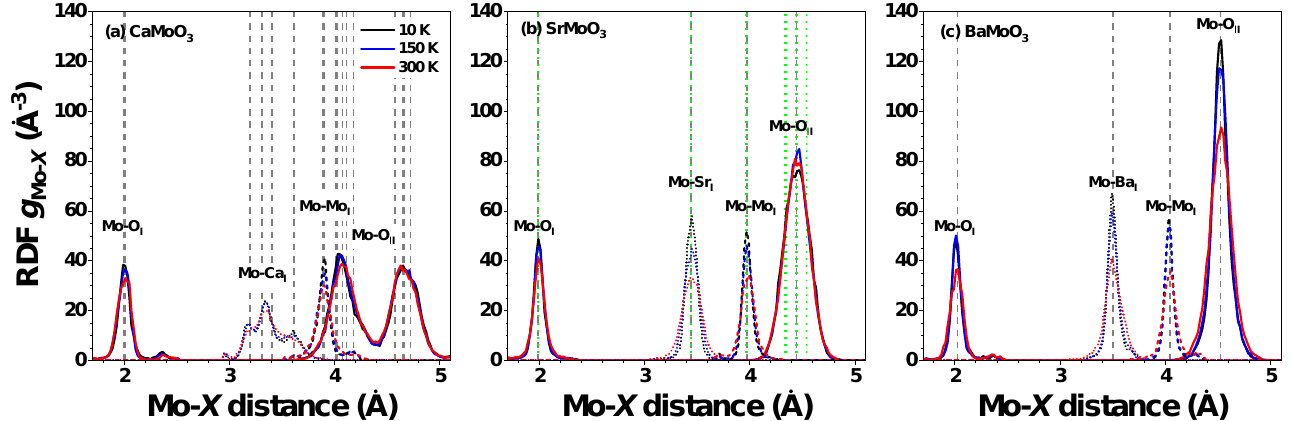
Figure 3. Radial distribution functions (RDFs) g Mo- X ( r ) in polycrystalline ( a ) CaMoO 3 , ( b ) SrMoO 3 , and ( c ) BaMoO 3 at 10 K, 150 K, and 300 K. Green and grey vertical dashed lines correspond to the average inter-atomic distances as obtained by XRD at 5 and 300 K, respectively. See text for details.